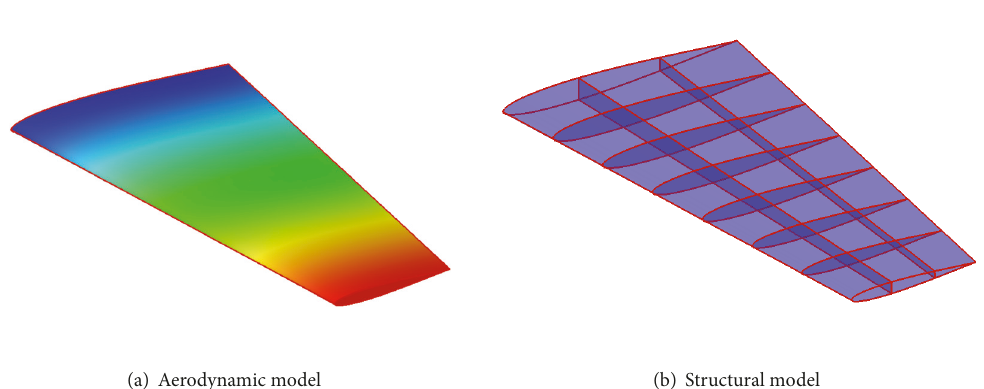
Figure 7: The aerodynamic model and structural model of wing.